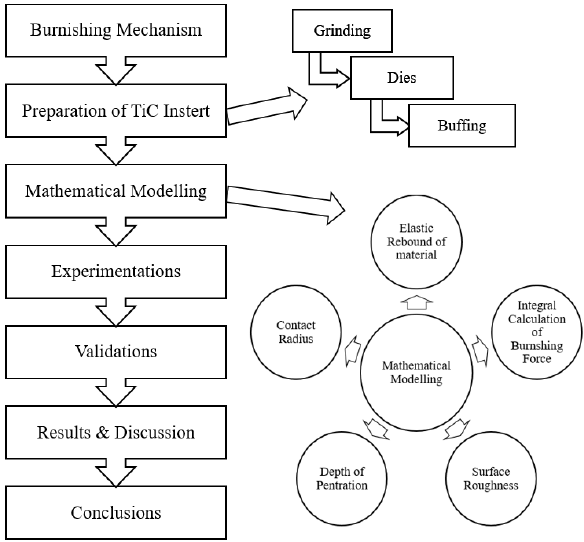
Figure 1. A flow chart of the burnishing process.